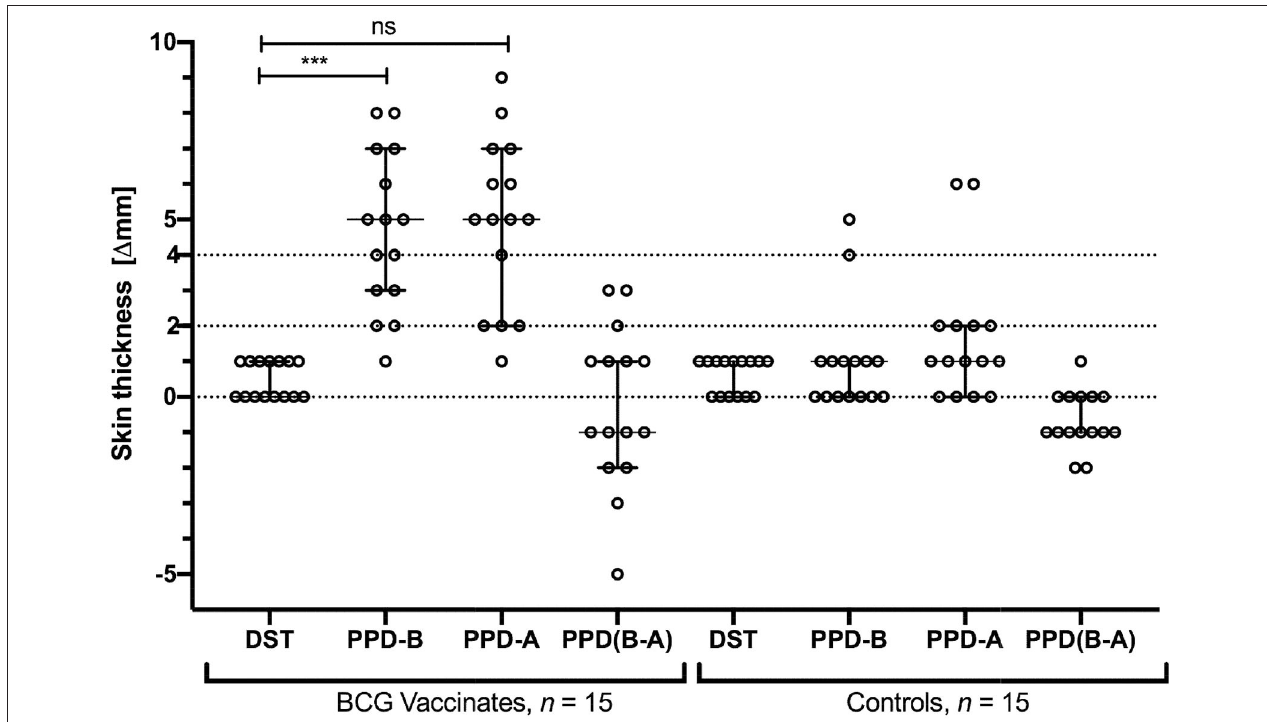
FIGURE 3 | Skin test responses induced by DST, PPD-B, and PPD-A were measured 72h post-injection in calves vaccinated with BCG ( n = 15) and naïve controls ( n = 15). Results are expressed as the difference in skin thickness (in millimeters) between pre- and post-skin test readings, with the horizontal line providing the median [ ± 95% confidence interval (CI)]. The statistical difference between the responses was determined using Friedman test (*** P < 0.001). The dotted horizontal lines at 2 and 4mm are the cutoffs used for DST, and PPD-B and PPD (B-A), respectively. The two control animals that are SIT positive are the same two that show > 4mm PPD-A